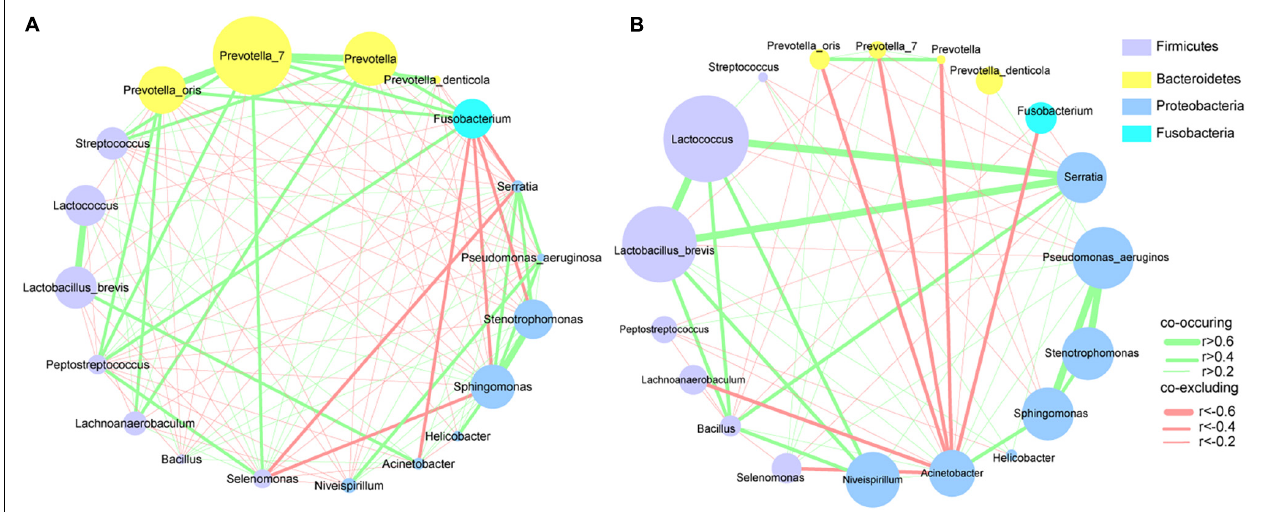
FIGURE 4 | Correlation networks of differential bacteria (A) in cancer and (B) non-cancer tissues. A subset of significant correlations with strengths of at least 0.2 were selected for visualization. The size of the nodes correspond to weighted node connectivity (WNC)